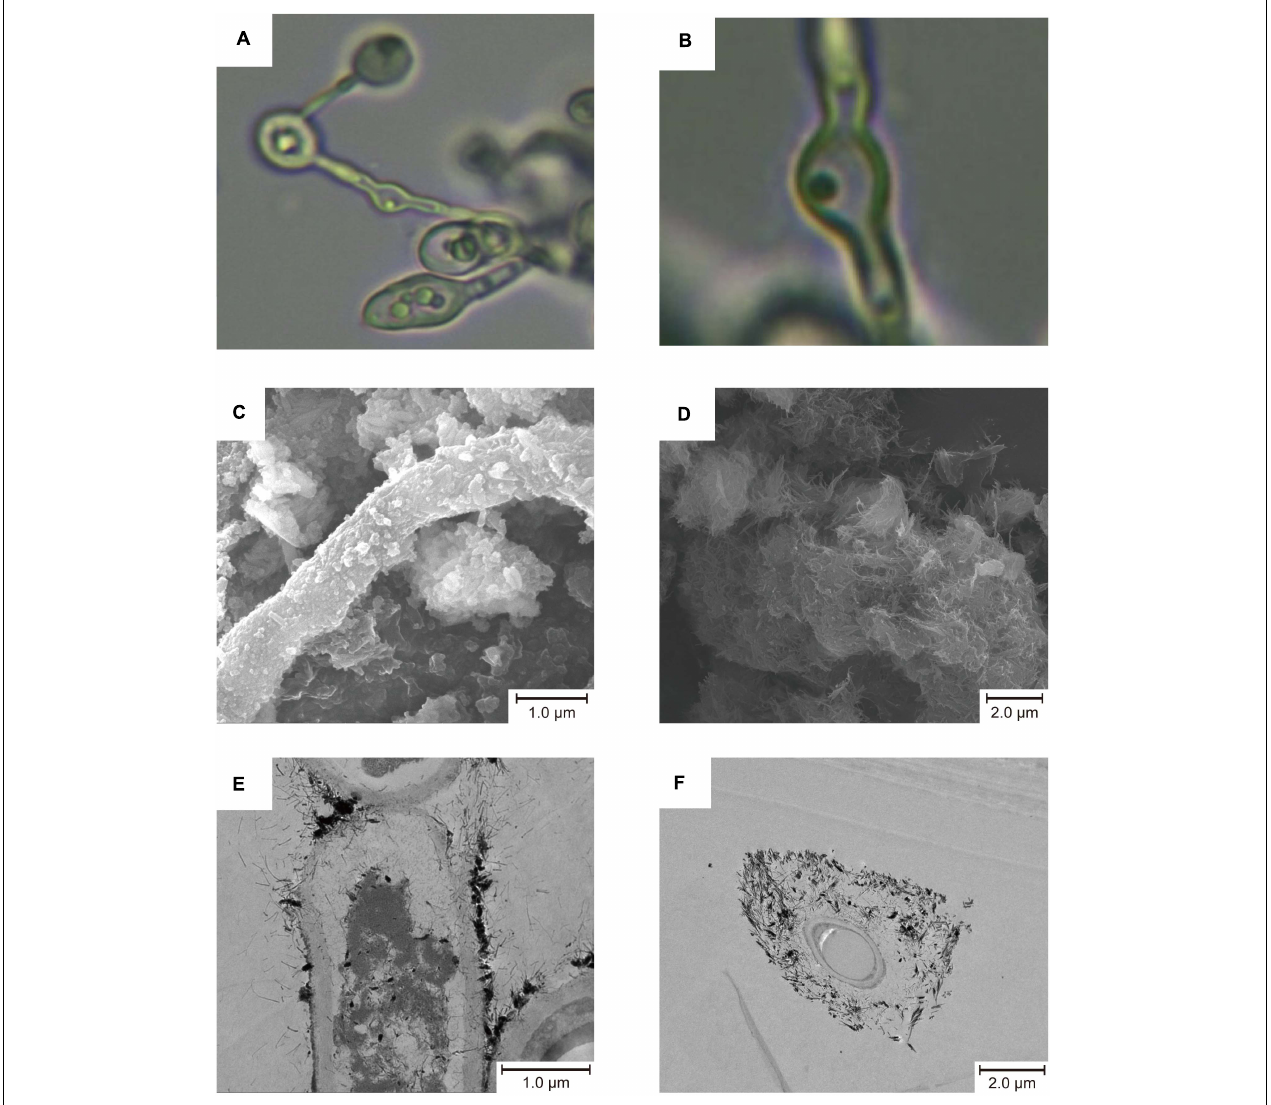
FIGURE 1 | Micro morphology of A. bohemica (A,B) , SEM micrographs (C,D) , and TEM micrographs (E,F) . (A,B) The mycelial morphology of A. bohemica . (C) Particles deposited on the fungal hyphae. (D) Acicular precipitates gathered. (E) Mineralization started on the surface of the fungal cell wall. (F) The fungal cell was completely surrounded by